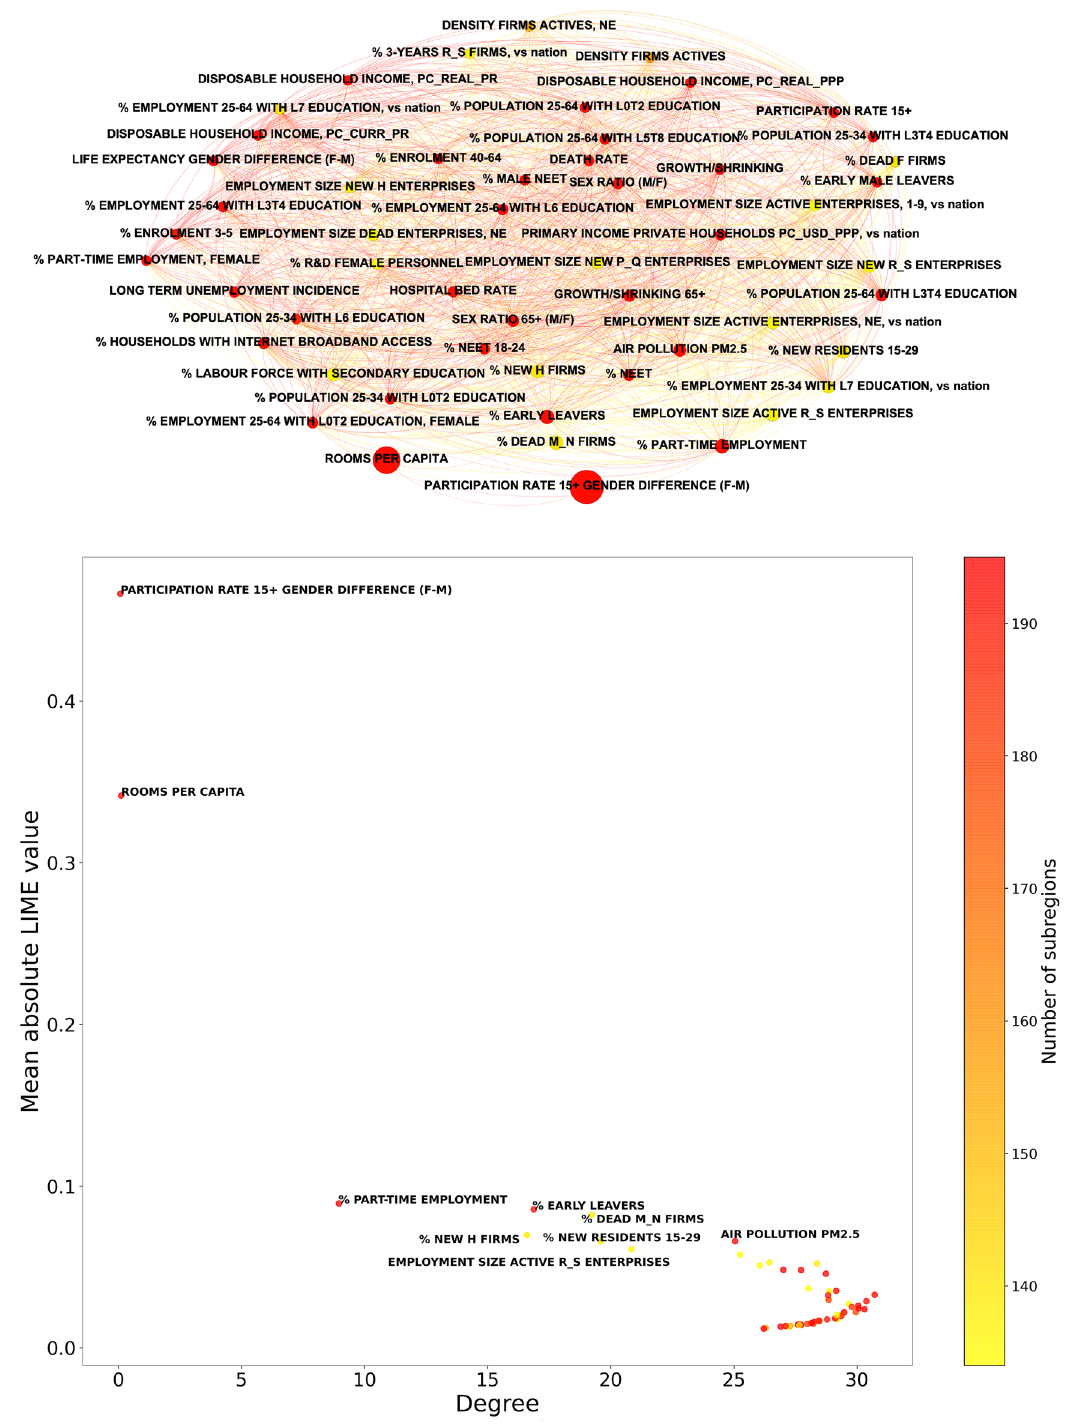
Figure 5. Top: competition network of the selected OECD indicators, determined from the importance rankings of their mean absolute LIME values for each subregion considered in the study. Bottom: scatter plot illustrating the relation between the mean absolute LIME value and the degree in the competition network, for indicator; labels are reported only for features whose mean absolute LIME value exceeds 0.06. In both panels, the color of points indicates the number of regions for which the considered indicator is available in the dataset. In the top panel, the size of each node increases with the mean absolute LIME value of the corresponding indicator. As in the case of SHAP values, the results confirm that both PARTICIPATION RATE 15+ GENDER DIFFERENCE (F-M) and ROOMS PER CAPITA are outstandingly relevant in their capability to predict EQI. The meaning of all the feature labels is explained in the Supplementary Data S1–S4. The network representation in top panel is generated with Gephi 0.9.5 48